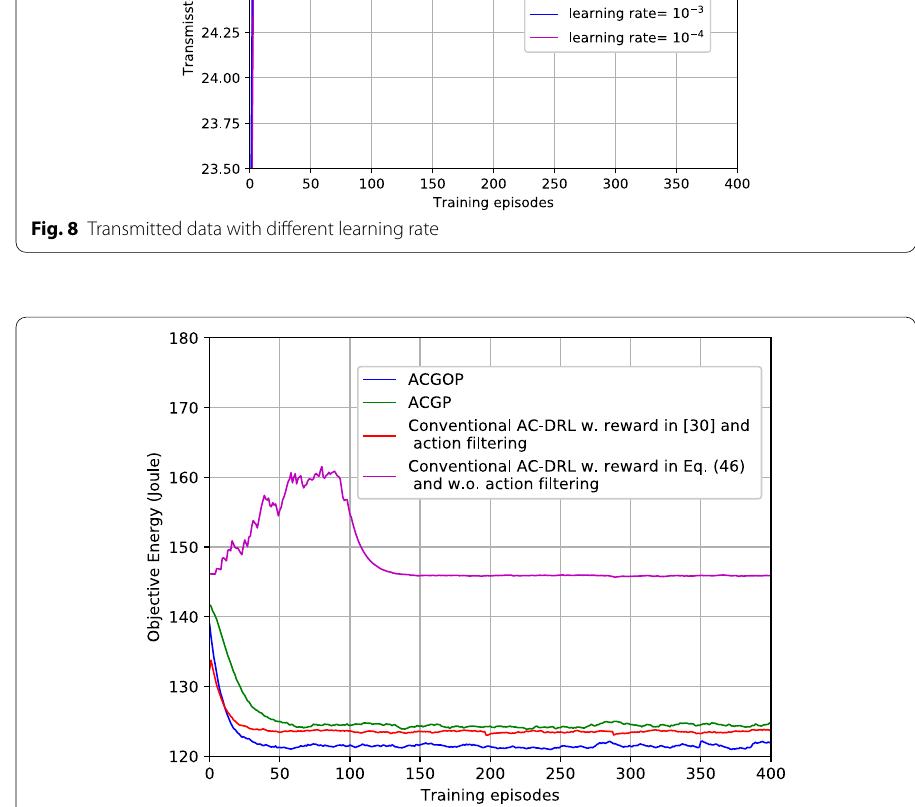
Fig. 9 Objective energy with different AC-DRL